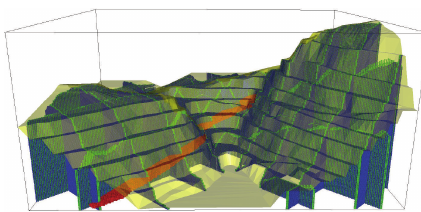
Figure 7: Resulting spheres with different colors that adhere to dis- continuities.